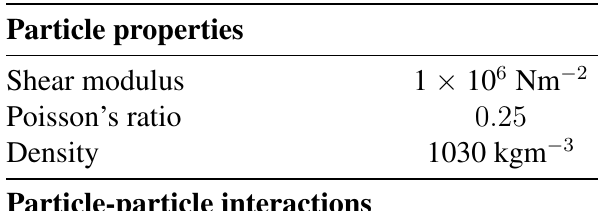
Table 1. DEM simulation